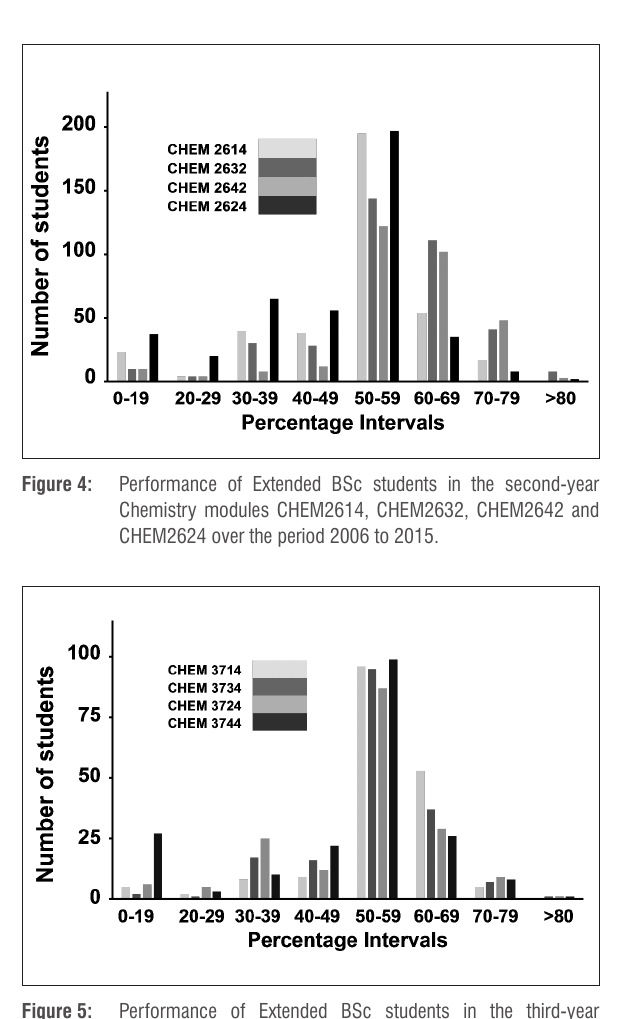
Figure 5: Performance of Extended BSc students in the third-year Chemistry modules CHEM3714, CHEM3734, CHEM3724 and CHEM3744 over the period 2007 to 2015.